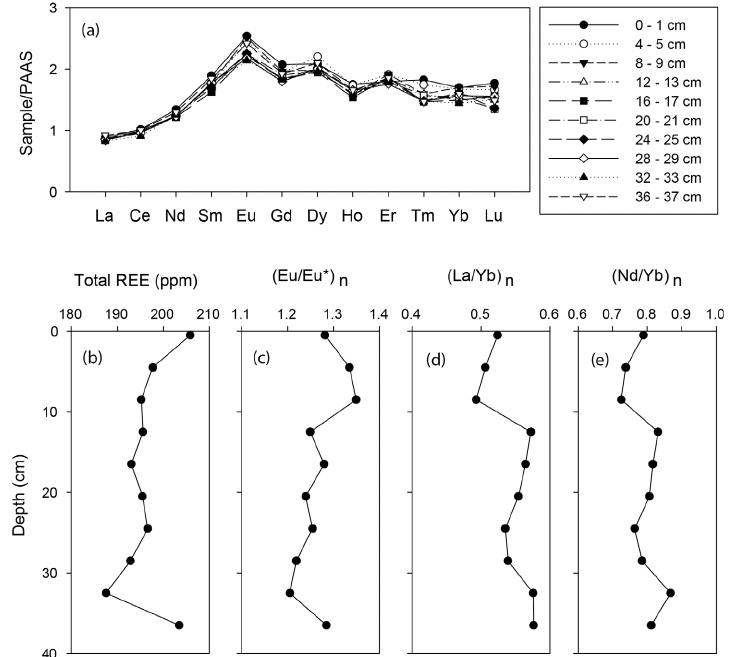
Figure 6. ( a ) Shale-normalized REE pattern and down-core variations of ( b ) total REE, ( c ) (Eu/Eu*)n ( d ) (La/Yb)n, and ( e ) (Nd/Yb)n for bulk sediments of the core BC-10. ( d ) (La/Yb)n, and ( e ) (Nd/Yb)n for bulk sediments of the core